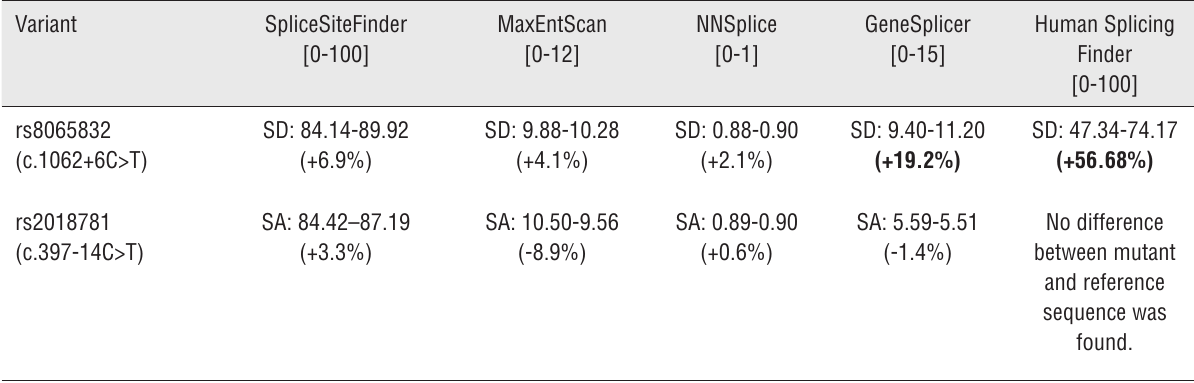
Table 3 - In silico splicing analysis of the intronic variants of unknown clinical relevance. Variant